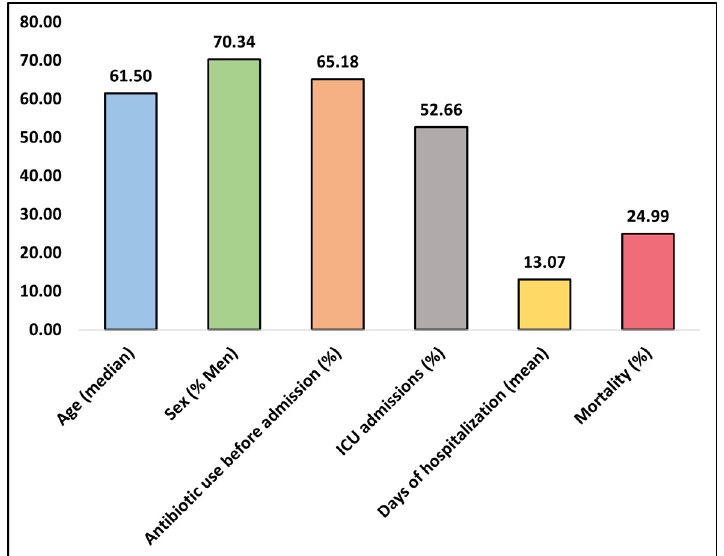
Figure 2. Summary of findings.